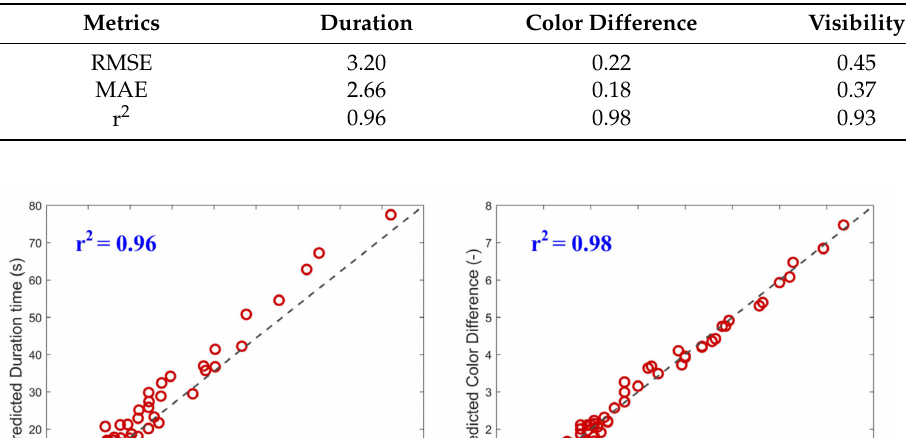
Table 12. Evaluation metrics for the machine learning model.